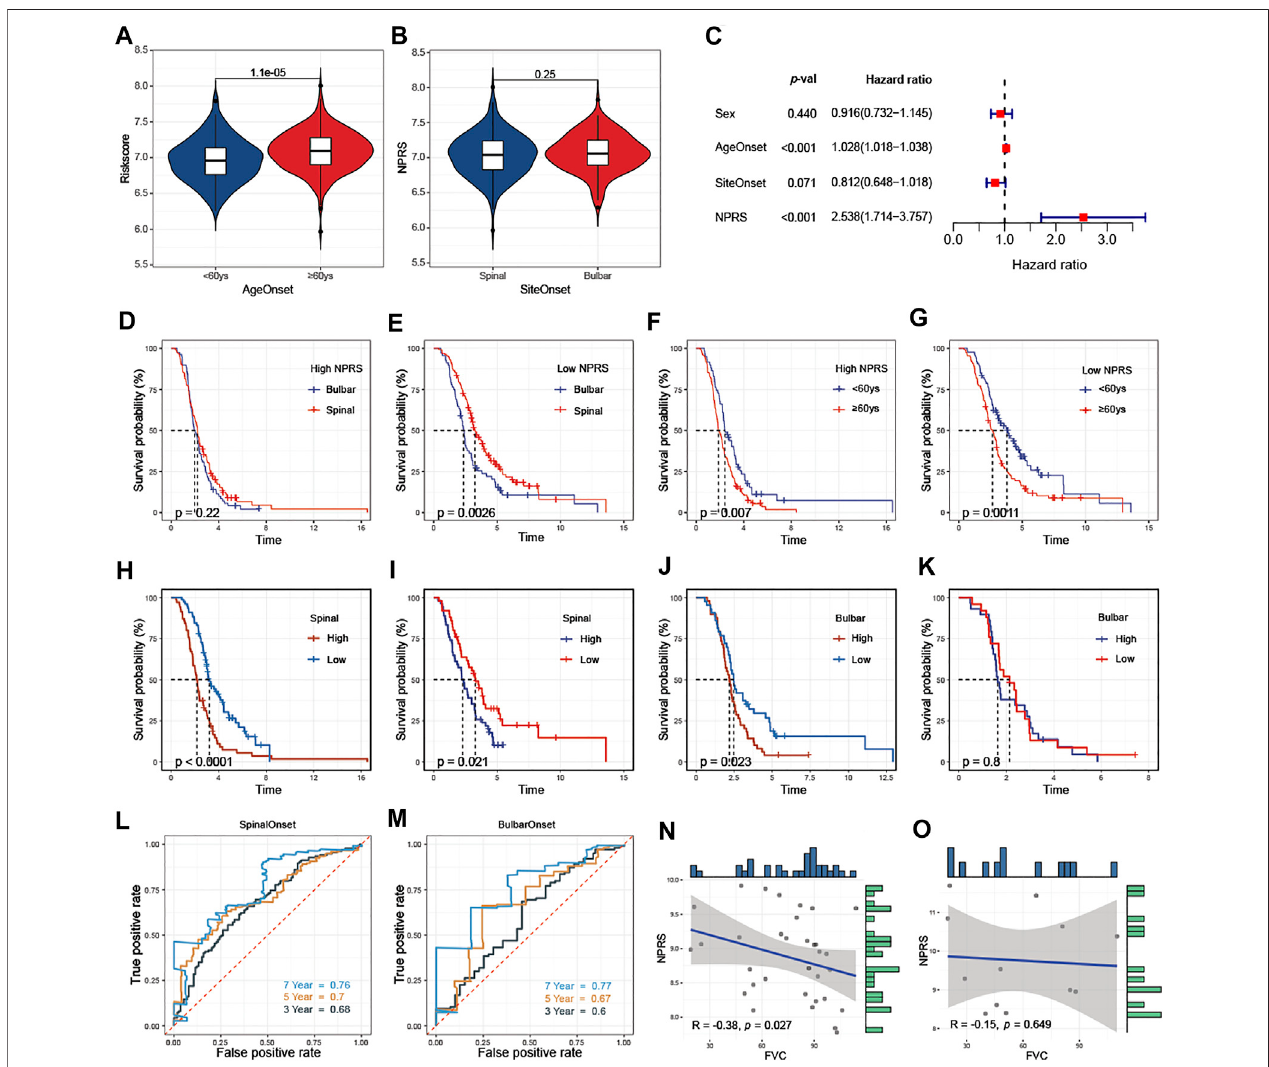
FIGURE 7 | Association of NPRS with clinicopathological features (A) NPRS was signi fi cantly higher in patients with elderly onset (B) There was no difference in NPRS between patients with different sites of onset (C) Age at onset and NPRS were independent prognostic risk factors in the multivariate COX regression model (D) and (E) Progression in patients with high NPRS (D) is not affected by site of disease onset, while survival differences are observed in patients with low risk scores (E) (F) and (G) Differences in survival risk by age of onset are not affected by high- (F) or low- (G) NPRS patients. Comparison of the prognostic capacities and survival outcomesofthe riskscore forpatientswith different features ofonset (H) and (I) Both intraining (H) and validation (I)cohorts, high-NPRS patients withspinal onset have poor survival (J) and (K) In the bulbar onset group, high-NPRS patients showed worsen survival compare to the low-NPRS group in the training cohort (J) but without survival differences between high- and low- NPRS patients in the validation cohort (K) (L) and (M) In the entire cohort, time-dependent receiver operating characteristic analysisofNPRS inpredicting the survivalofALSpatientswithspinal (L) or bulbar (M)onset (N) and (O) InE-TABM-940,negative correlatedbetween NPRS and FVCin ALS patients with spinal onset (N) but not in patients with bulbar onset